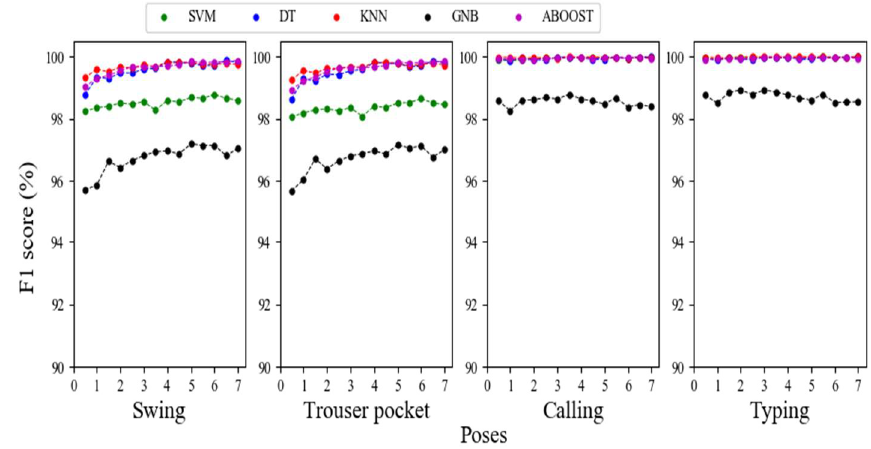
Figure 10. Relationship between F1 score and window length for pose classification.